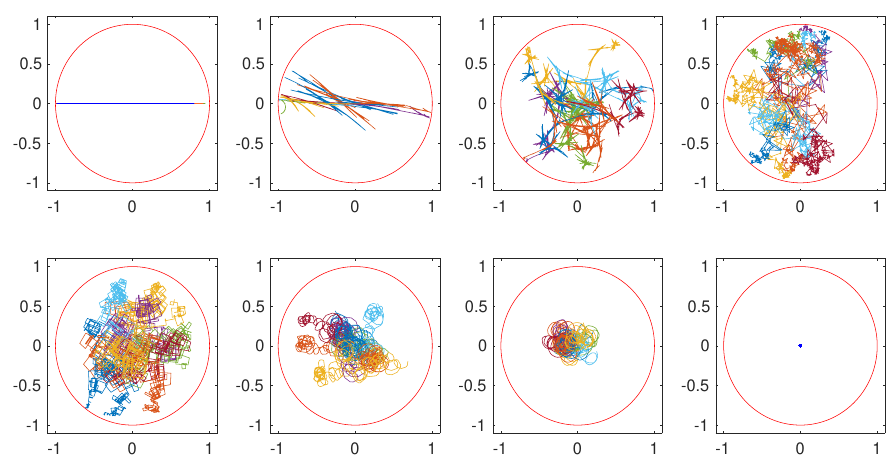
Figure 29: Trajectory of ρ on the unit disk (cid:68) with n = 200 steps of random driving. n The driving protocol and parameters are the same as those in Fig. 7. We choose θ randomly distributed in [ 0,0.2 ] . From left to right (and then top to bottom), we − 1 / 2 = 0, 0.0005, 0.01, 0.1, 0.25, 0.4, 0.48, and 0.5, choose ∆ T / l : = T θ / l θ eff ,eff = respectively. The number of random samples are N sample